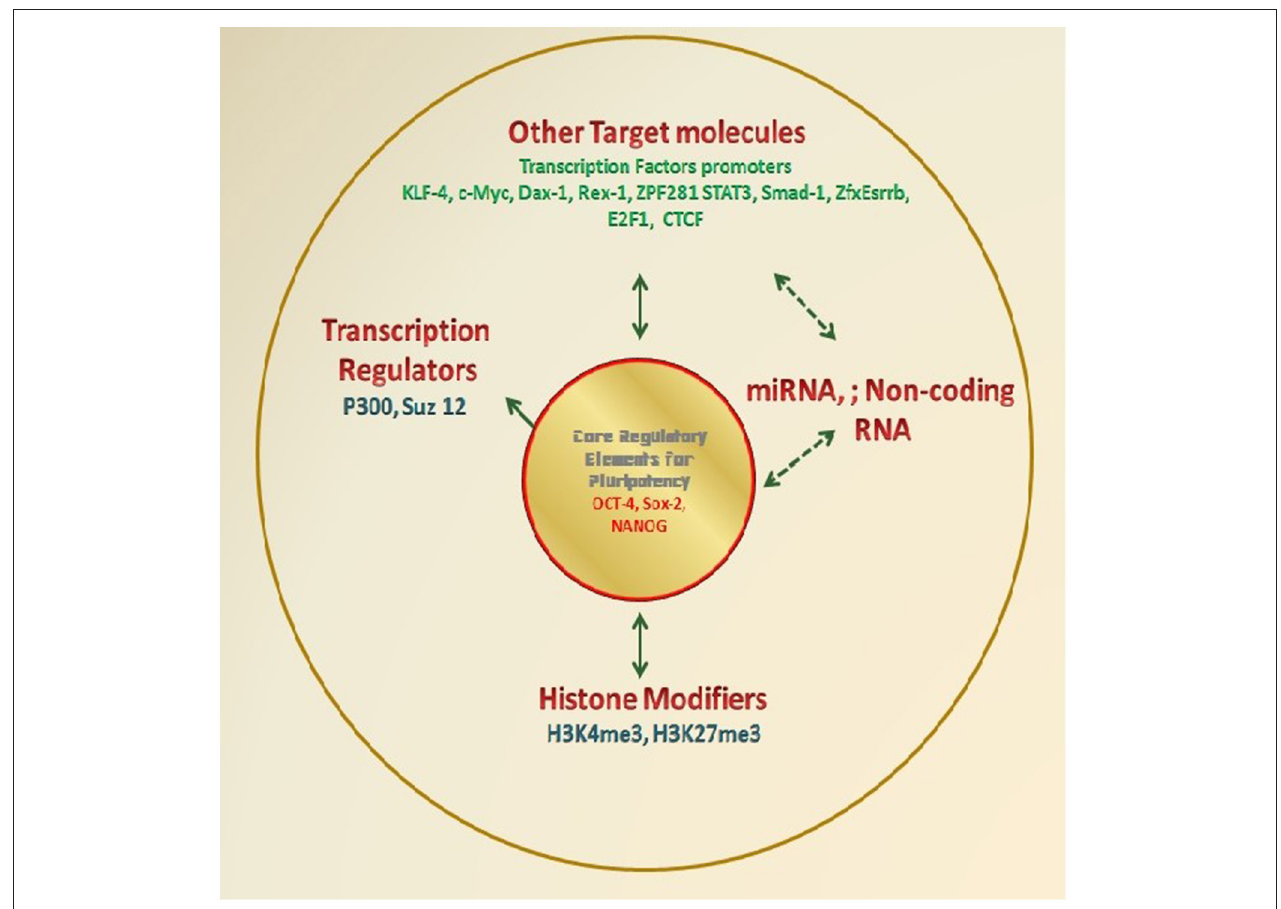
FIGURE 2 | Molecular diagnostics for determination of Pluripotency. Various research groups have demonstrated the molecular markers especially TFs which essentially regulate the self-renewal and differentiation potential of PSCs. These factors either directly regulate renewal/ differentiation through their binding to the target gene and therefore regulating target gene expression; or they themselves get regulated and are the target for a number of other transcription regulating elements such as miTNA, Noncoding RNA, Histone modifiers. Various researchers have wisely used these factors as the marker to define the potential of any test cells as an alternate approach to the standard functional